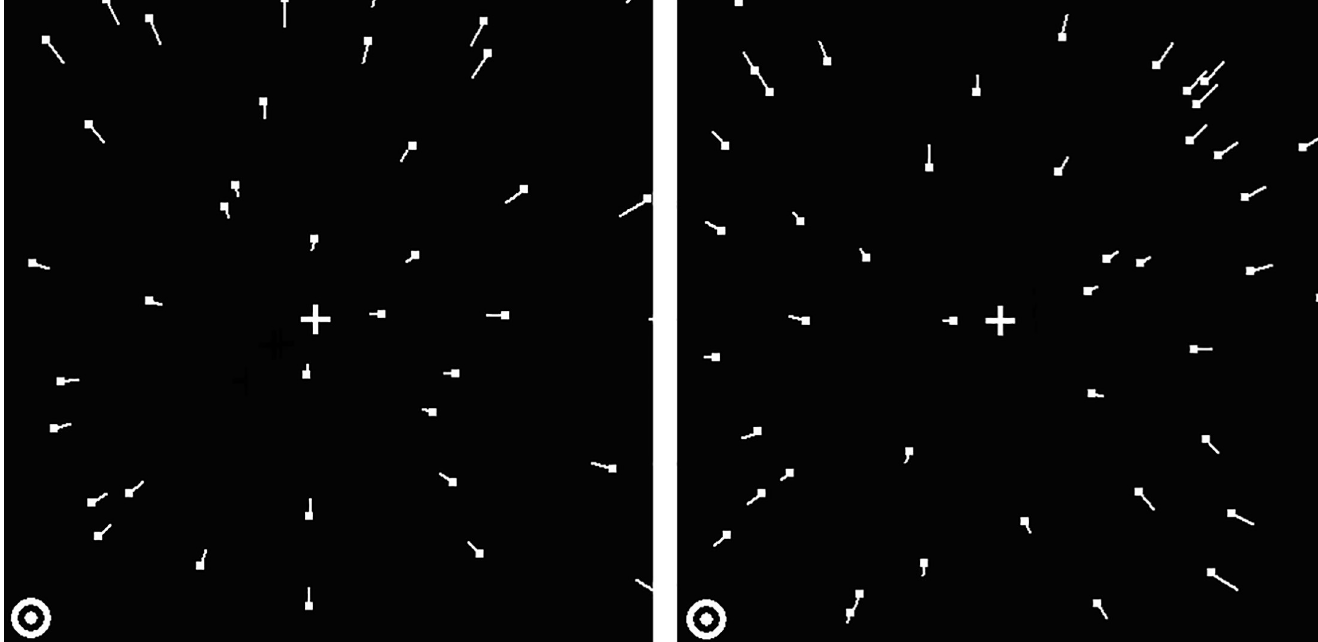
Fig 1. Schematic representations of a contracting (left panel) and an expanding (right panel) optic flow pattern in Experiment 1. In this example, both optic flow patterns were presented in the upper right visual quadrant. In the other three conditions, both flow patterns were presented in one of the other three quadrants. Short white lines (not present in the experimental displays) show the direction of the trajectories of the moving dots (dots are shown at the start of their trajectory). The white cross in each panel (not present in the experimental display) denotes the veridical centres of the flow patterns. The circle in the lower left corner of each panel denotes the fixation